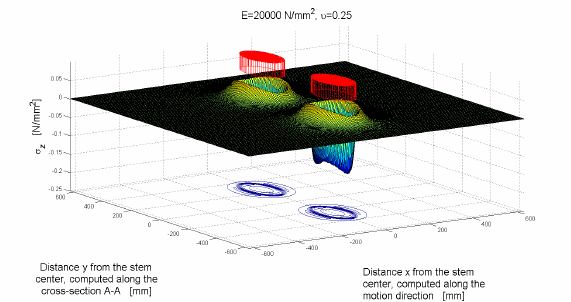
Figure 37: 3-D surfaces and stress contours of σ z near the surface for the interaction model of Figure 35 (second order solution).